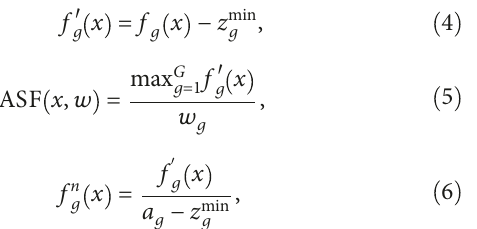
Table 3: The relationship between Boolean value and missile